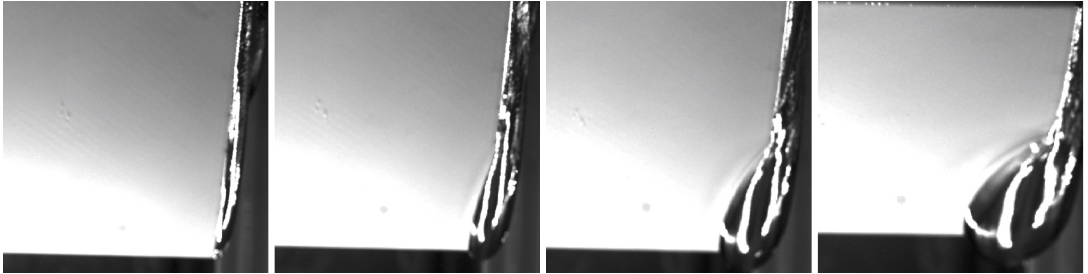
Figure 5. Details of the vertex of the keel at several time instants, presenting the evolution of the cavity formation. Images are taken from the